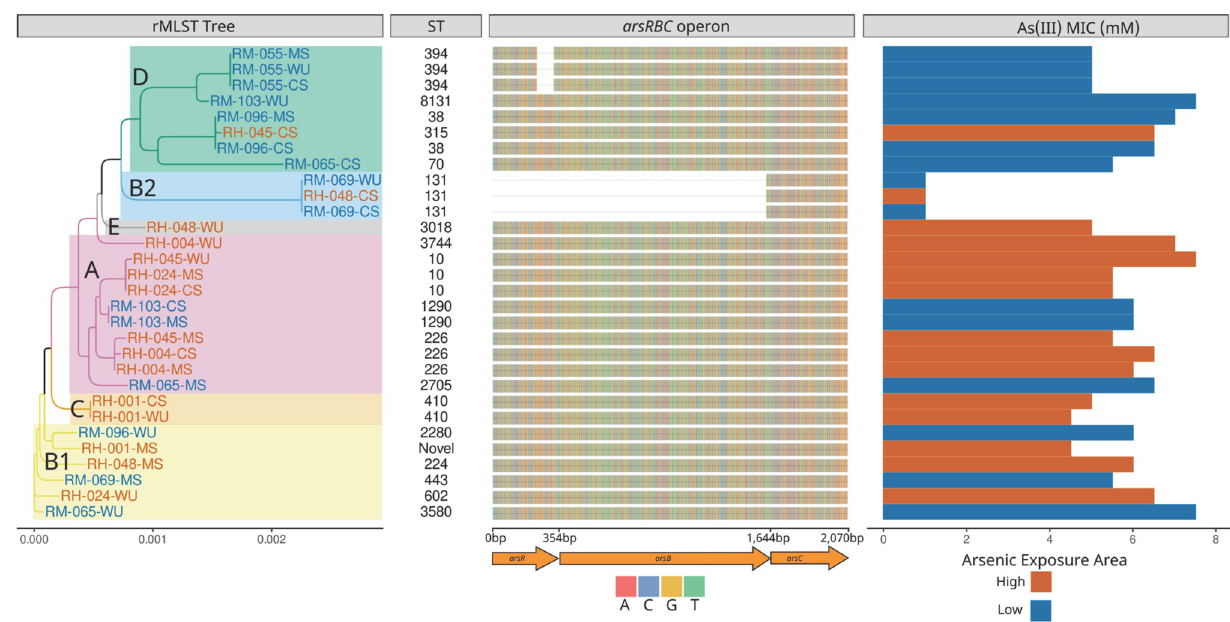
Fig 5. Neighbor-joining tree based on ribosomal MLST (rMLST) allele sequences for 30 E . coli isolates. Sequence types (STs), ars operon, and minimum inhibitory concentration (MIC) to arsenite are shown next to the tree. Colored leaves and shaded regions indicate the phylogroups. RH and RM in isolate ID indicate if the isolate was obtained from Hajiganj (high arsenic exposure) or Matlab (low arsenic exposure) areas, respectively. WU, MS, and CS in isolate ID indicate isolates from drinking water, mother stool, and child stool, respectively.